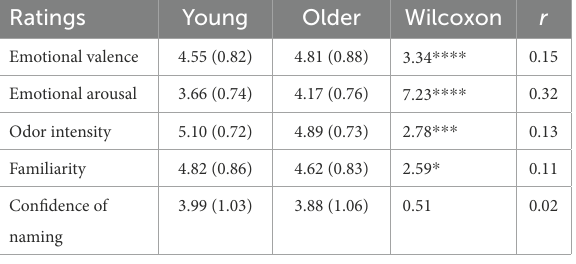
TABLE 3 Mean score (SD) on odor cognitive characteristics by each group.